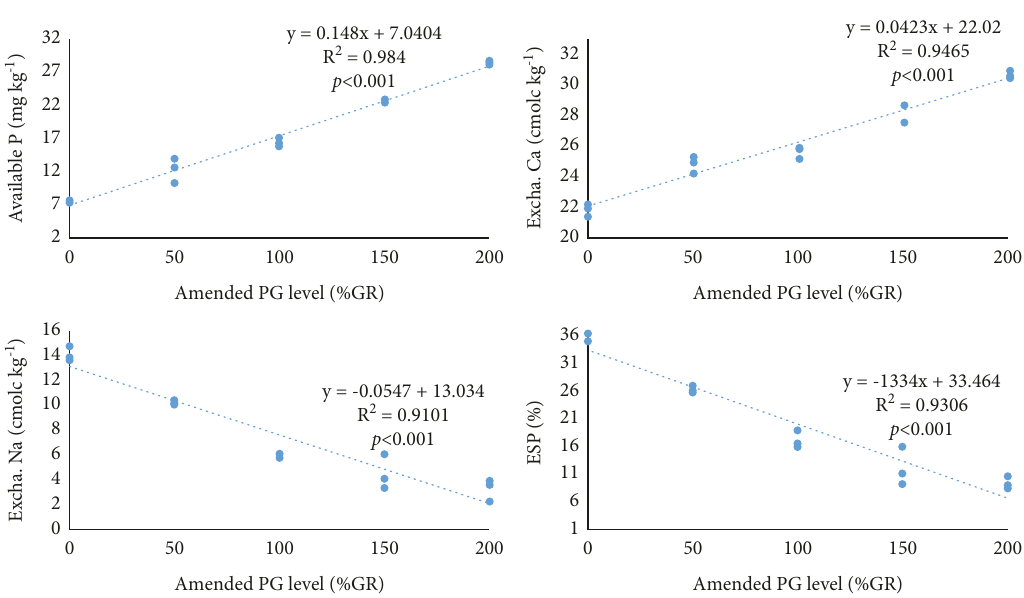
Figure 4: Relationship between chemical properties and application of PG levels after leaching.